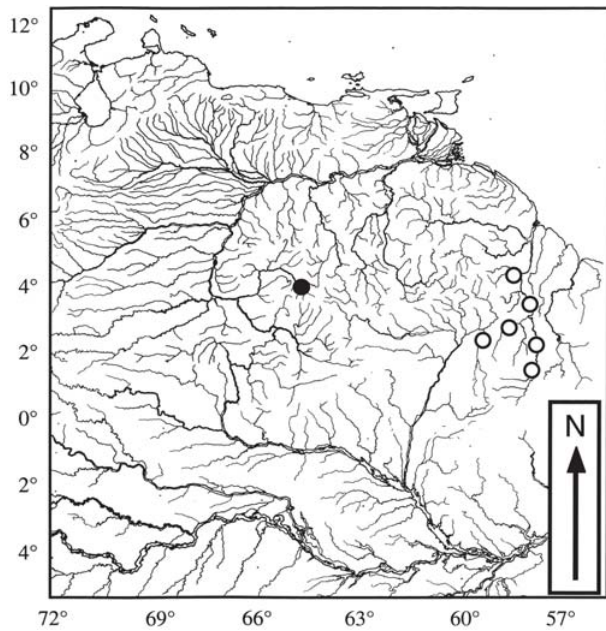
Fig. 2. Distribution of Lithoxus jantjae (filled circle) and L. lithoides (open circles), the geographically closest described species of Lithoxus .